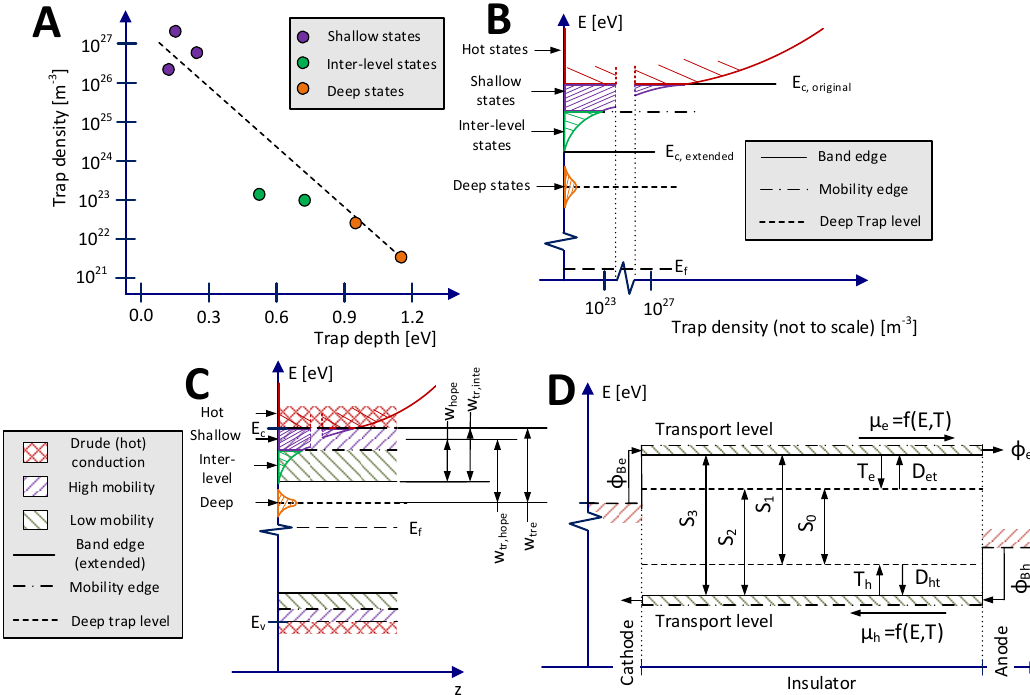
Figure 1. Trap densities and classifications in polyethylene ( A ) adapted from [8] and [12]. Extension of the band gap and the localized density of states (DOS) for electrons ( B ). Simplified description of the polyethylene band gap ( C ) and its corresponding effective mobility approach ( D ). Energy levels are not to scale. No representation of applied external electric field has been included in ( C ) and ( D ).